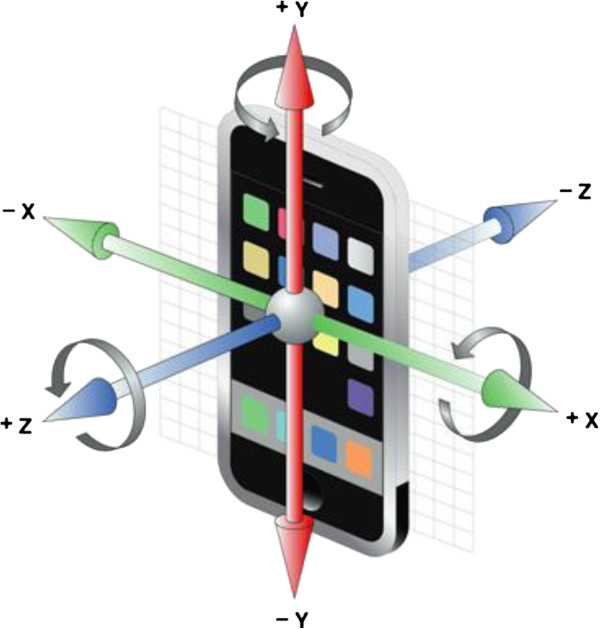
iPod rotation axes.